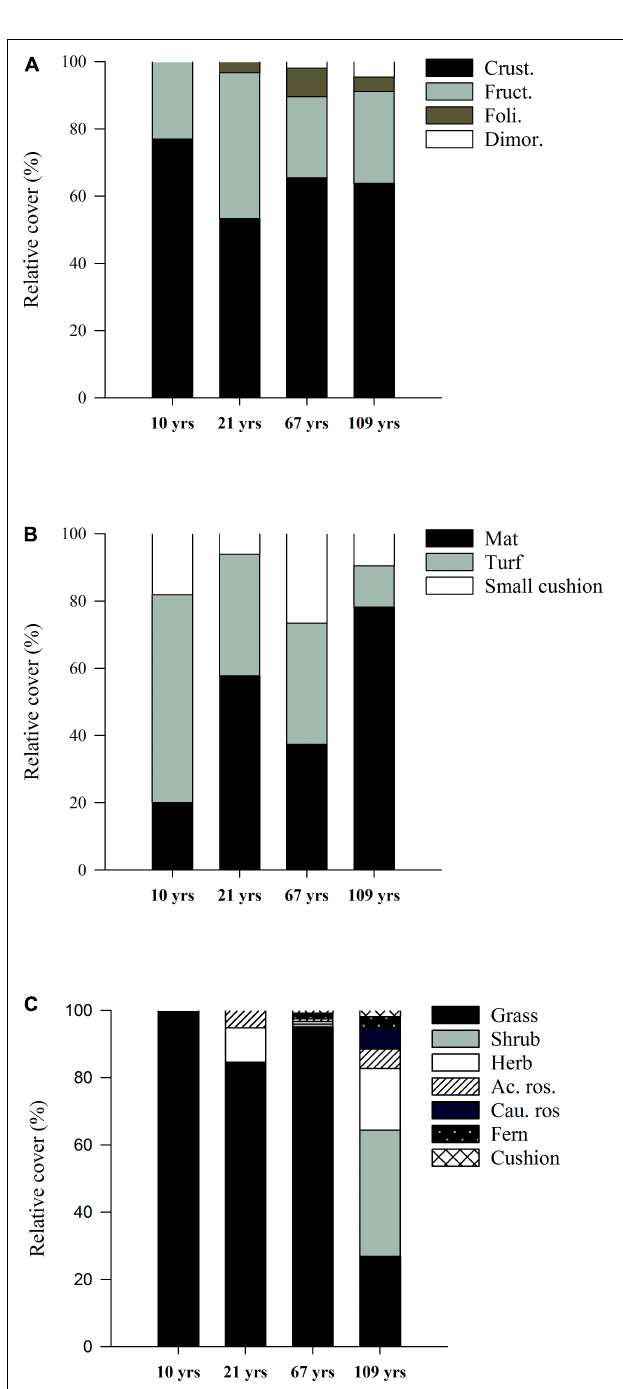
FIGURE 4 | Average relative cover (%) of the different growth forms of lichens (A) , bryophytes (B) and vascular plants (C) in four study sites (S1-S4) along a post-glacial chronosequence (10–109 years of succession) at Humboldt Peak, Venezuela.